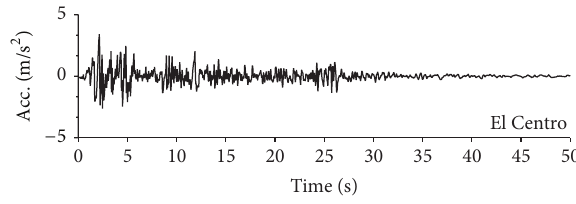
Figure 4: Original time histories of El Centro